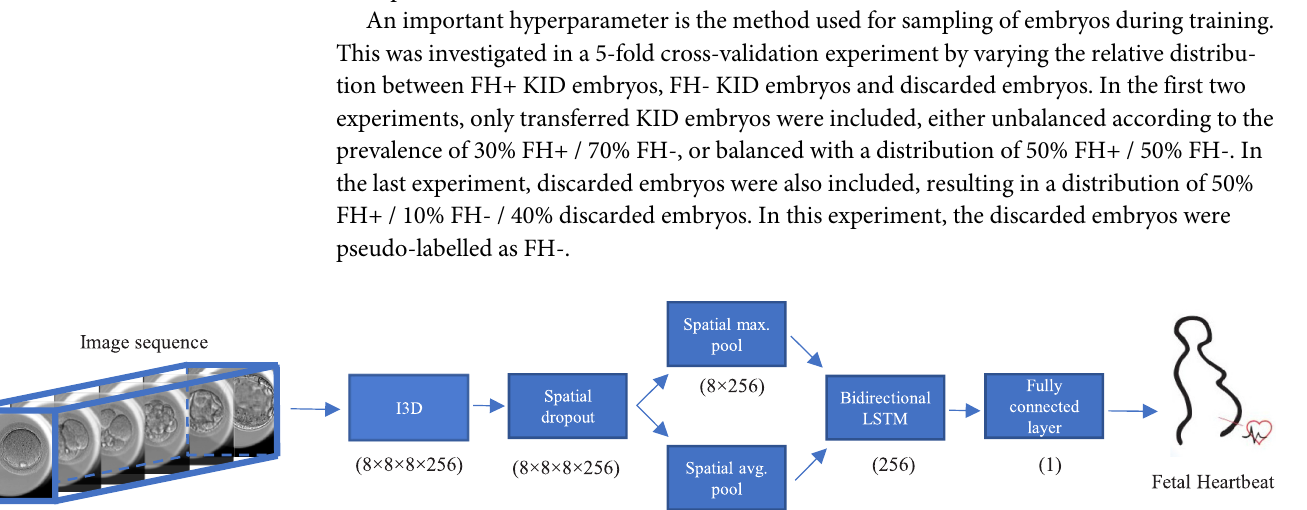
PLOS ONE | https://doi.org/10.1371/journal.pone.0262661 February 2,